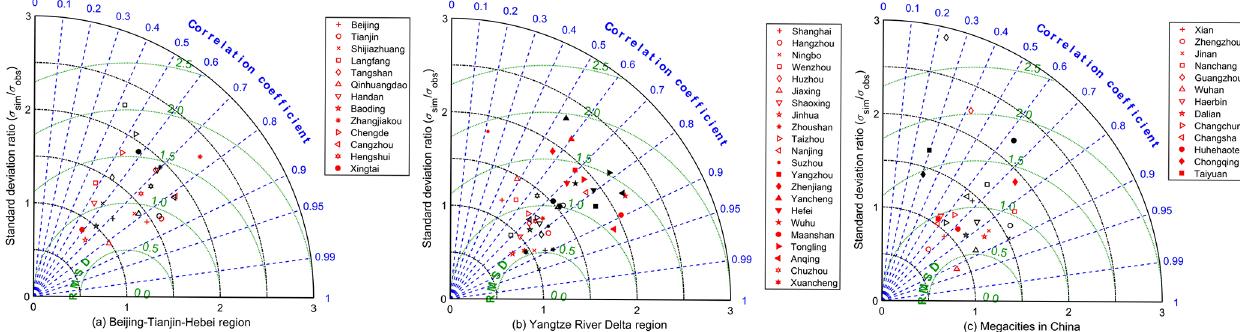
Figure 4. Taylor diagrams of hourly PM 2 . 5 concentrations during 22 to 27 January 2015 from the GEOS-Chem Classic nested-China simulation (black symbols) and the WRF-GC simulation (red symbols) for (a) 13 cities in the Beijing–Tianjin–Hebei area, (b) 22 cities in the Yangtze River Delta area, and (c) 13 other major Chinese cities. Dashed green, black, and blue lines indicate contours of the normalized centered root mean square differences (RMSDs), the ratios of simulated versus observed standard deviation, and the Pearson correlation coefficients, respectively.